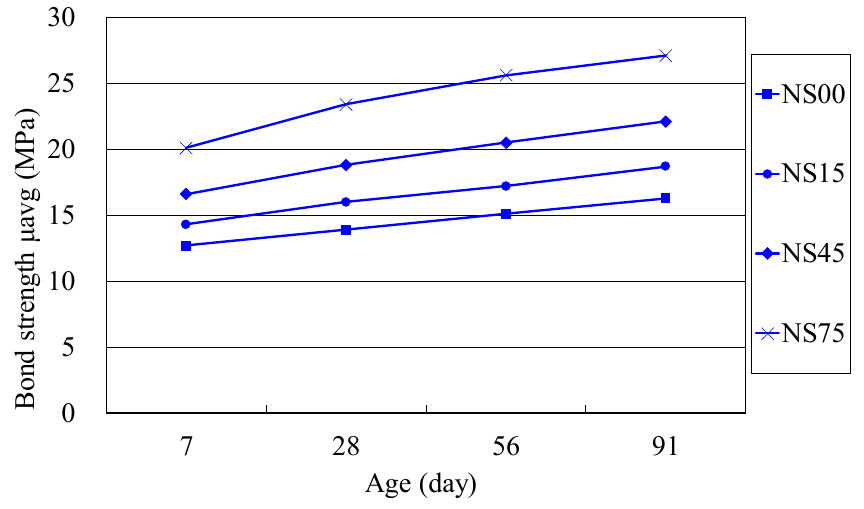
Figure 5. Bond strength of NAC versus curing age.